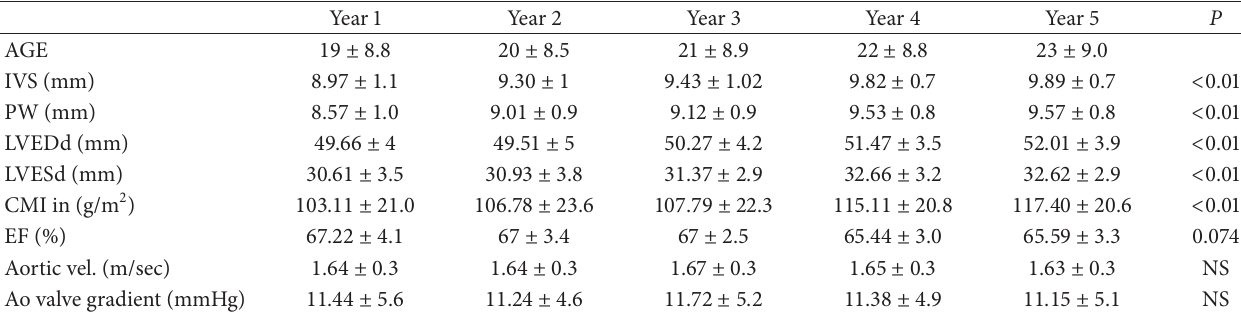
Table 3: BAV athletes: details of echocardiographic parameters during the 5-year followup.